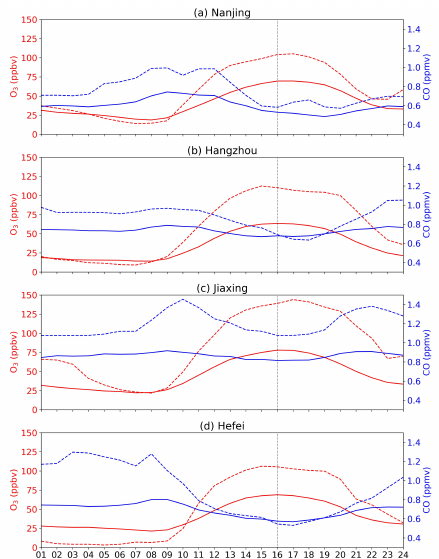
Figure 3. Mean diurnal cycle of ozone (red) and CO (blue) averaged over the month (April 2018, solid lines) and for the severe ozone pollution days (27–28 April 2018, dashed lines). ( a ) Nanjing, ( b ) Hangzhou, ( c ) Jiaxing and ( d ) Hefei. The vertical black dotted lines indicate 16:00 of local time, which is approximately the peak of the diurnal cycle.